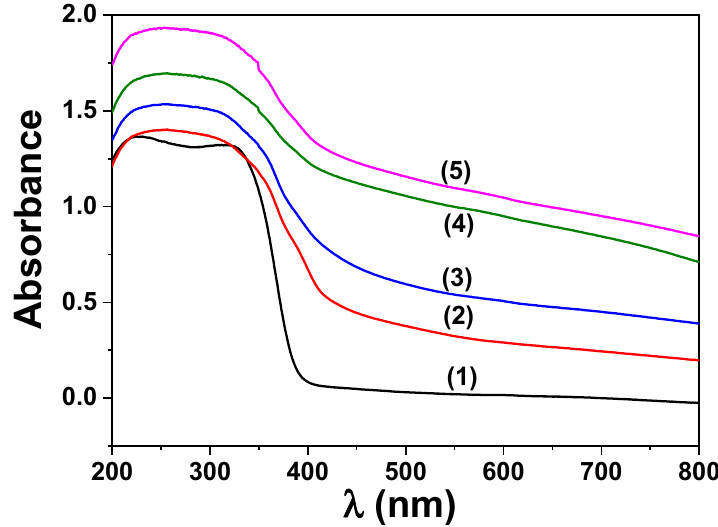
Figure 7. DRS spectra of STO ( 1 ), STO/MWCNTs ( 2 ), 1% CuO/STO/MWCNTs ( 3 ), 3% CuO/STO/MWCNTs ( 4 ), and 5% CuO/STO/MWCNTs ( 5 ). The band gap energy has a significant parameter effect on the photocatalytic activity of catalysts. Thus, the band gap energy ( E g ) of the as-prepared samples was calculated by their UV − Vis optical absorption spectrum and presented in the inset of Figure 8 [40]. As shown in Figure 8, the band gap values of the pure STO, STO/MWCNTs, and x% CuO/STO/MWCNTs (x = 1, 3, 5) samples were found to be 3.23, 2.86, 2.74, 2.38, and 2.25 eV, respectively. Generally, the band gap energy value of the nanocomposites decreased with increasing CuO content.